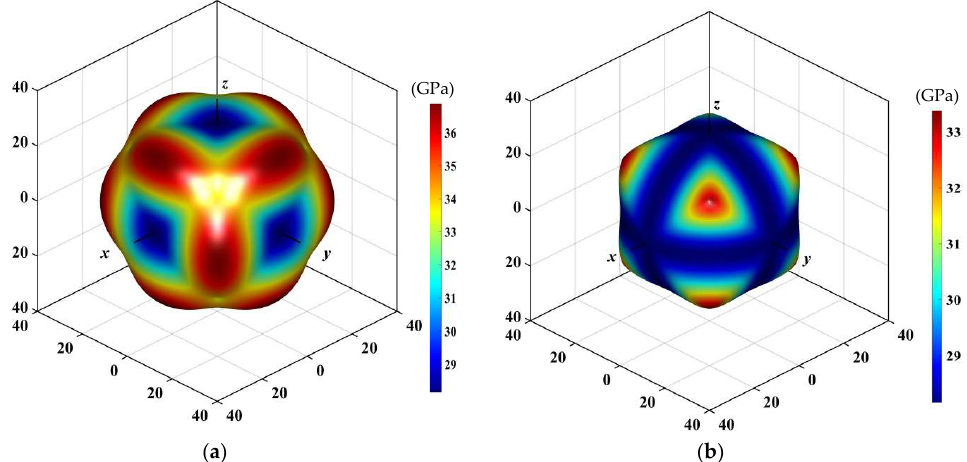
Figure 4. Three-dimensional surface representation of ( a ) maximum shear modulus and ( b ) minimum shear modulus of Ag 9 In 4 .